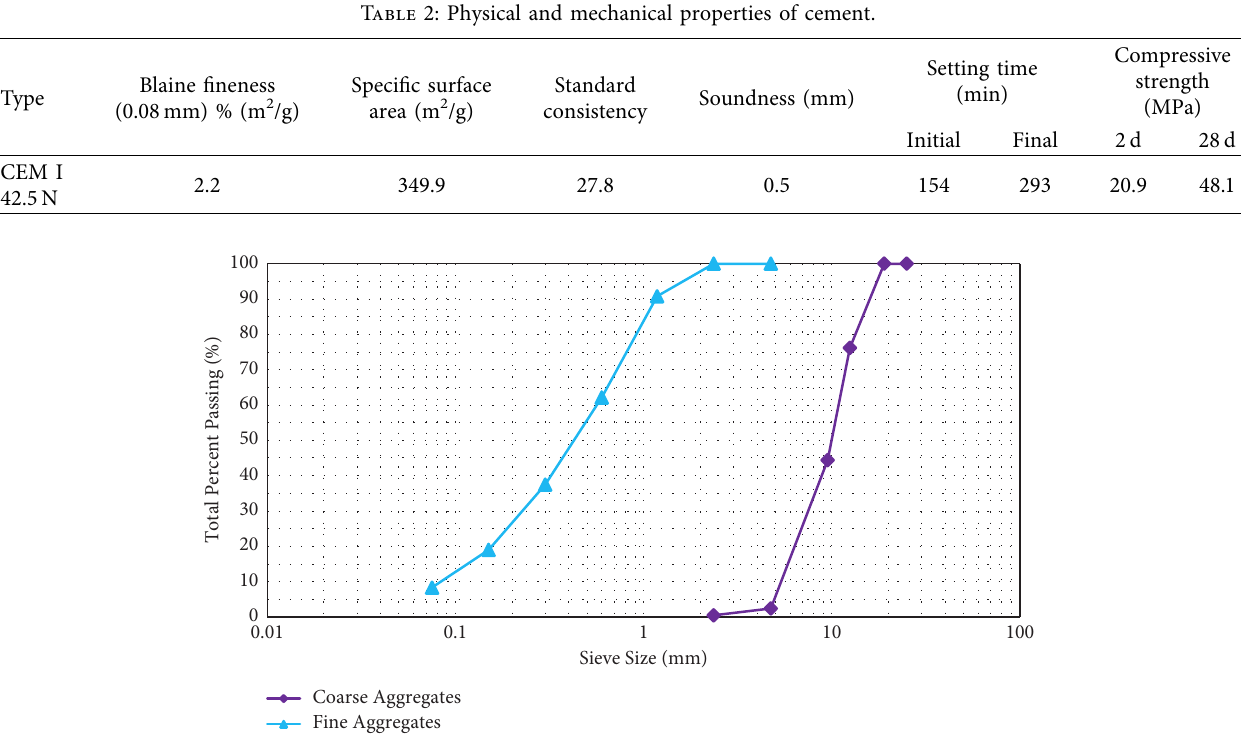
Figure 1: Particle size distribution of coarse and fine aggregates. Table 3: Physical properties of